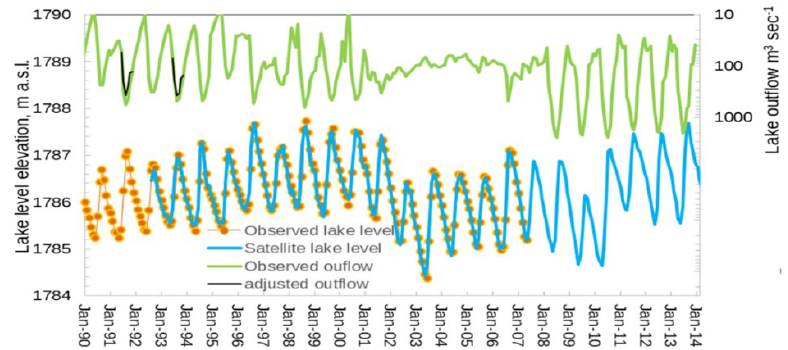
Figure 6. Observed and adjusted satellite lake levels [48] and observed and adjusted outflow from the Lake Tana.